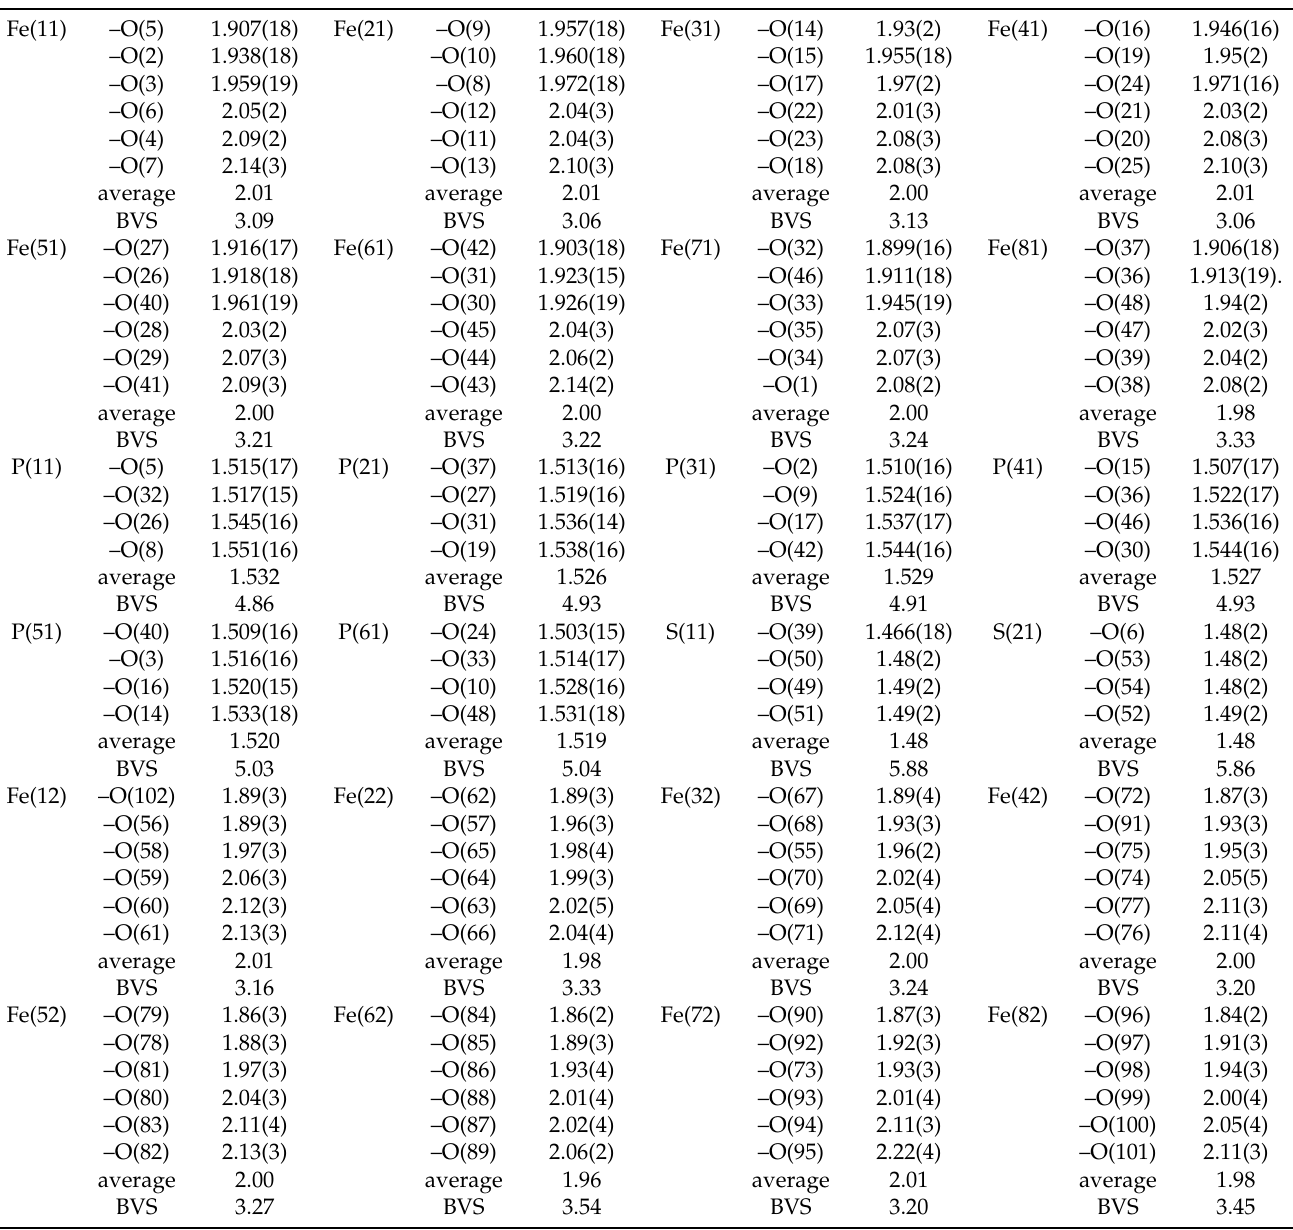
Table 2. Selected bond distances (Å) and bond-valence sums (BVS, in valence units) for cation sites in